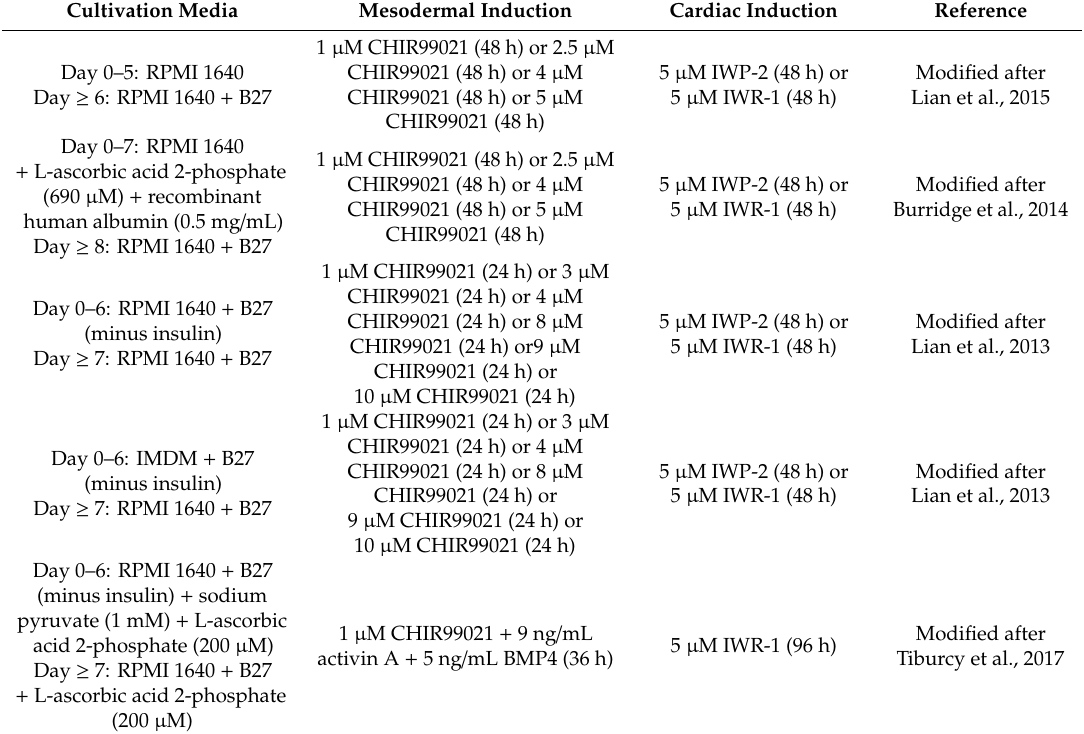
Table 2. Tested conditions for directed cardiac di ff erentiation of NHP-PSCs.